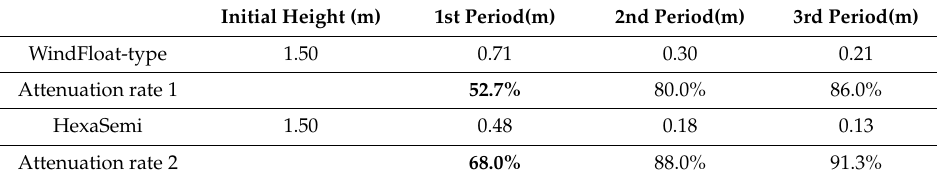
Table 4. The attenuation rate of heave free decay curves of the two platforms.